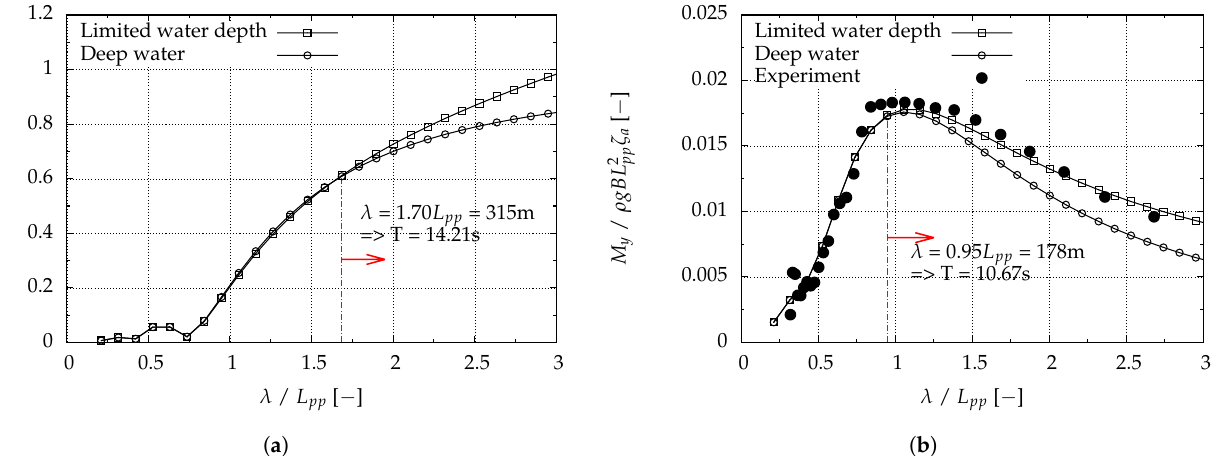
Figure 10. LNG carrier: with Green functions boundary element method computed effects of water depth on ( a ) surge motion and ( b ) midship vertical bending